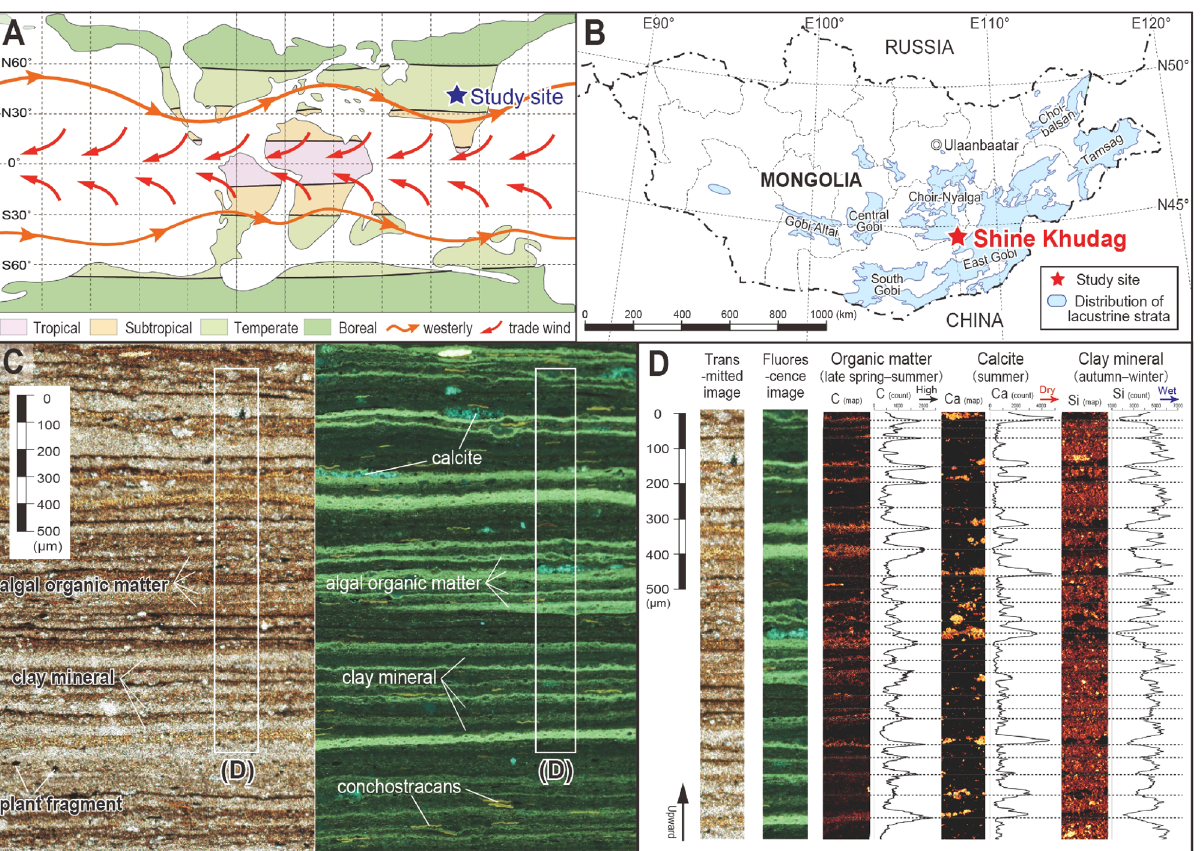
Figure 1. Palaeogeographic map, location, photomicrographs, and laminae compositions of the studied Mongolian lacustrine deposits. ( A ) Reconstructed mid-Cretaceous palaeoclimatic zonation and palaeo-wind patterns 40 . ( B ) Distribution of Lower Cretaceous lacustrine strata and location of study site in Mongolia 39 . ( C ) Photomicrographs of tens of micrometer-scale laminae in shale bed taken under transmitted (left) and reflected fluorescence (right) light. ( D ) Elemental composition of lamina couplets based on SEM–EDX analysis, consisting of micrometer-scale alternations of organic carbon (fluorescent algal OM), lenticular micritic calcite aggregates, and detrital clay mineral (less fluorescent) layers, in ascending